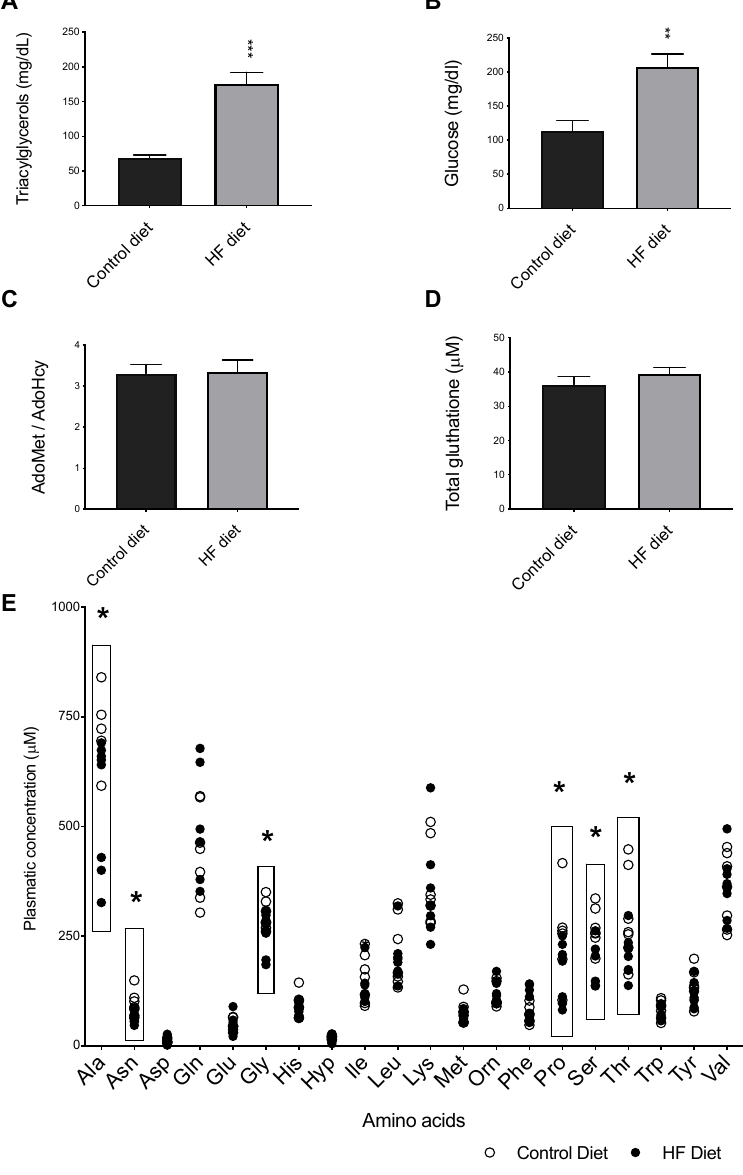
Figure 3. The effect of control and High-Fat (HF) diets on circulating concentrations of triacylglycerols ( A ), glucose ( B ), S-adenosylmethionine to S-adenosylhomocysteine ratio (AdoMet/AdoHcy) ( C ), total glutathione ( D ), and amino acids ( E ). (Ala, alanine; Gly, glycine; Val, valine; Leu, leucine; Ile, isoleucine; Thr, threonine; Ser, serine; Pro, proline; Asn, asparagine; Asp, aspartate; Met, methionine; Hyp, hydroxyproline; Glu, glutamate; Phe, phenylalanine; Gln, glutamine; Orn, ornithine, Lys, lysine; His, histidine; Tyr, tyrosine; Trp, tryptophan). Data shown are the mean ± SEM (n = 6–9 per group); * p < 0.05; ** p < 0.01; *** p < 0.001; HF versus control.